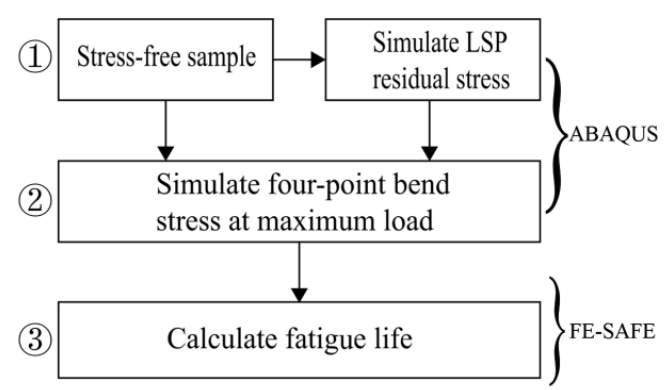
Figure 2. Framework of numerical modeling.